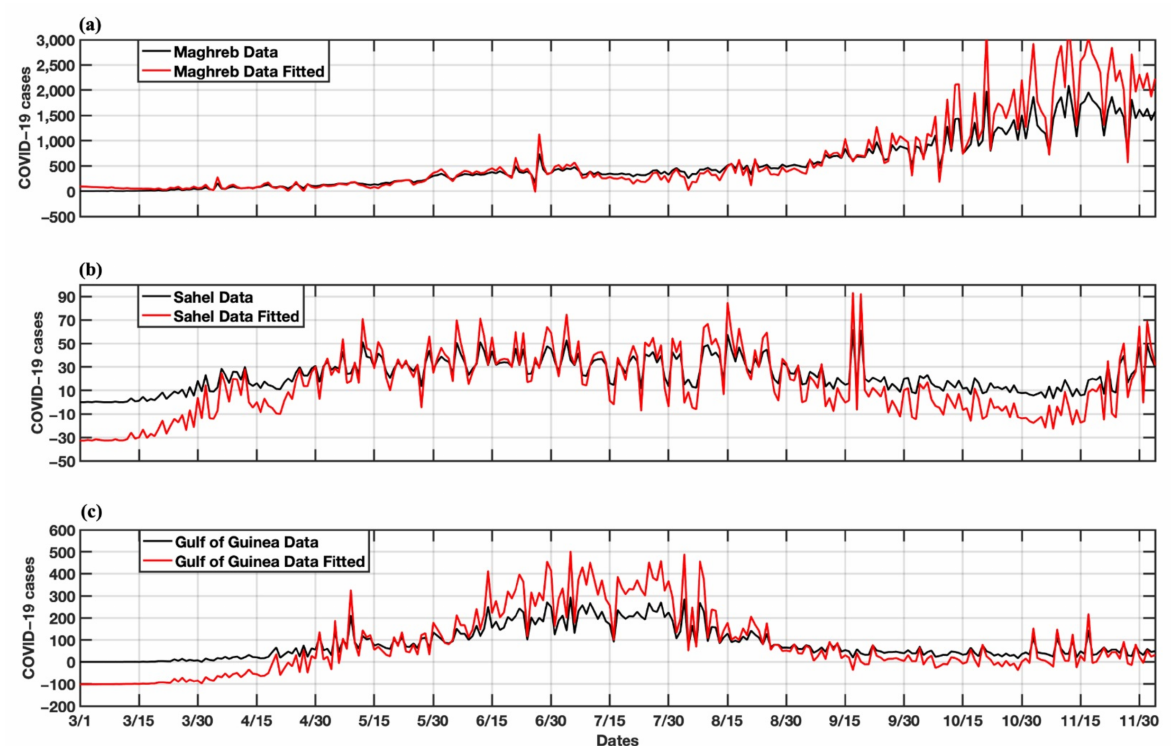
Figure 4. COVID-19 confirmed cases fitted by an MBLM model [49], extrapolated from the observed COVID-19 data over the ( a ) Maghreb, ( b ) Sahel, and ( c ) Gulf of Guinea regions. The residuals (i.e., the differences between the MBLM fitted curve and the observed